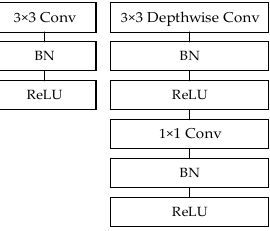
Figure 2. Traditional convolution (left), MBConv convolution block (right).